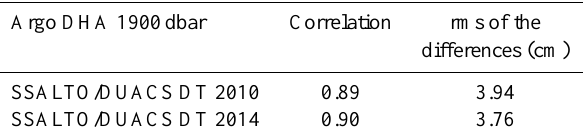
Table 1. Statistics (correlation computed with a 95% confidence interval) between altimeter products and in situ DHA with an ho- mogeneous reference period of the altimeter SLA and in situ DHA (2003–2011) in the Bay of Bengal ( − 5 ◦ S/ + 20 ◦ N; 80 ◦ E/95 ◦ E), Argo DHAs are referenced to